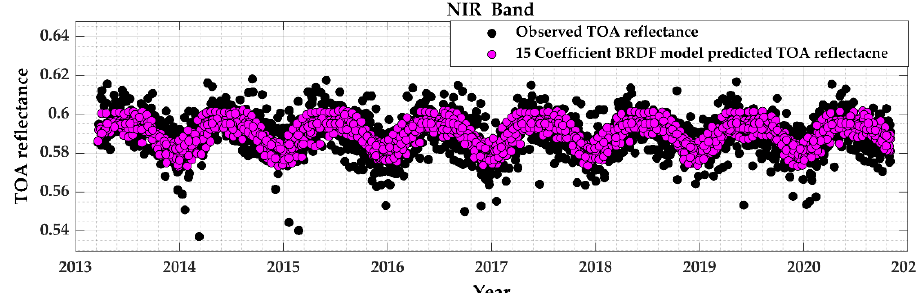
Figure 6. Comparison of the observed top of atmosphere (TOA) reflectance and the TOA reflectance predicted by the BRDF model.